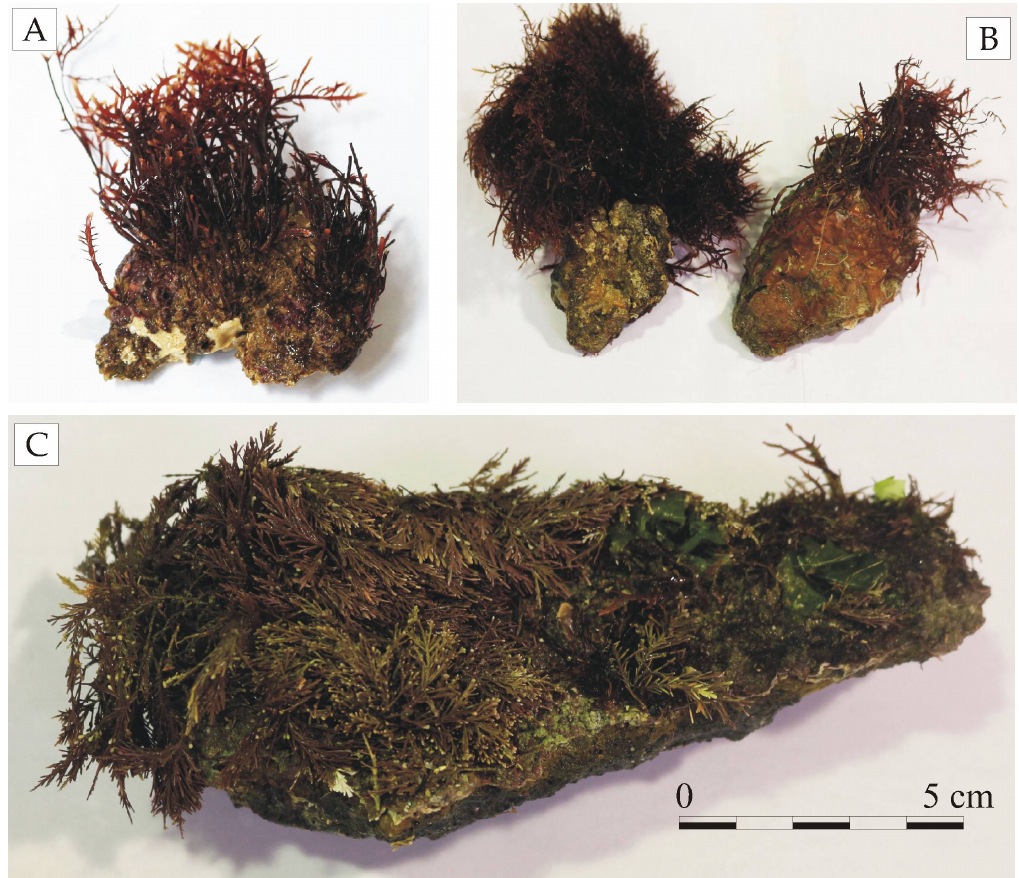
Figure 2. Some representative fragments of mortar from underwater archaeological site: ( A ) macroscopic aspect of the sample CN-2; ( B ) macroscopic aspect of the sample CN-7; ( C ) macroscopic aspect of the sample CN-13.